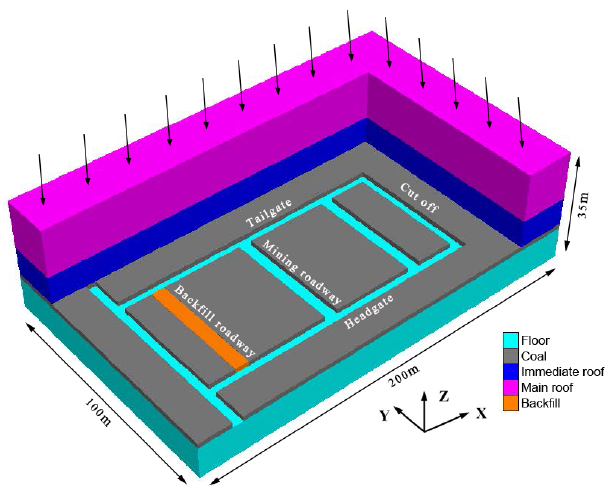
Figure 7. Numerical calculation model.